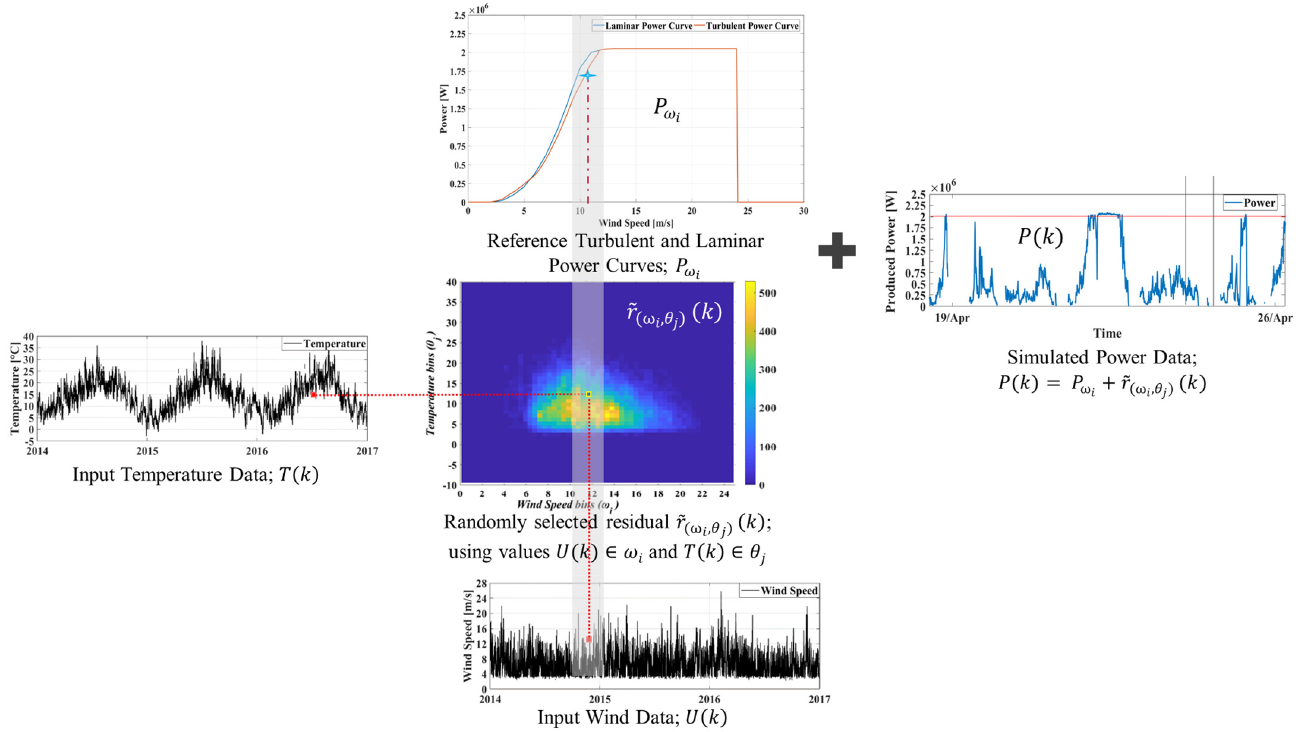
Figure 4. Overview of the simulation framework. Power P ( k ) is simulated by adding data dispersion (cid:101) r ( ω i , θ j ) ( k ) , randomly selected using input U ( k ) , T ( k )) pair and reference power curves P ω i (laminar and